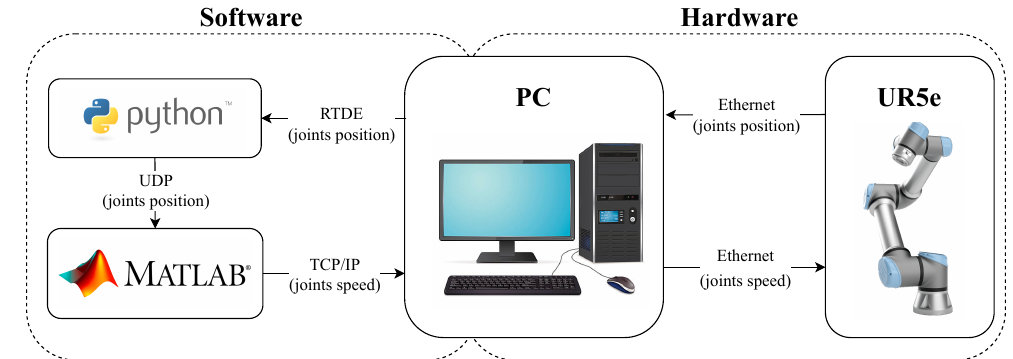
Figure 2. Software/hardware architecture: standard PC connected to a UR5e robot with a socket communication cable (compliant with TCP/IP standards); the PC receives in input the robot’s joint rotations and sends out the joint velocities reference signal. Software is realized by Python and Matlab development environments for communication and data processing.